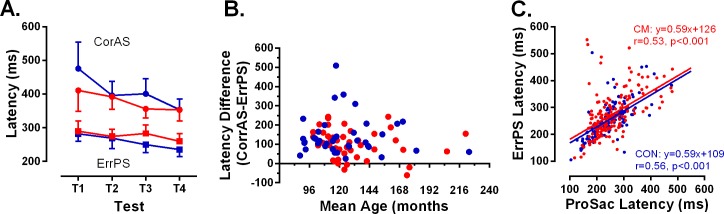
The latency of different types of saccade and their relationships.A. Intersubject mean (95% CI–upper or lower error bars plotted for clarity) averaged across each testing session. CM: Data plotted in red. CON: Data plotted in blue. ● correct antisaccades (CorAS); ■ error prosaccades (ErrPS). B. Plot of the difference between mean correct antisaccade latency (averaged over testing sessions) and mean error prosaccade latency for each participant against their age (calculated as the mean age over testing sessions). CM: red, CON: blue as in A. C. Correlation between prosaccade (ProSac) latency and error prosaccade (ErrPS) latency for all participants and sessions. CM: red, CON: blue as in A. Parameters of least-squares linear regression functions and correlation coefficients are shown.